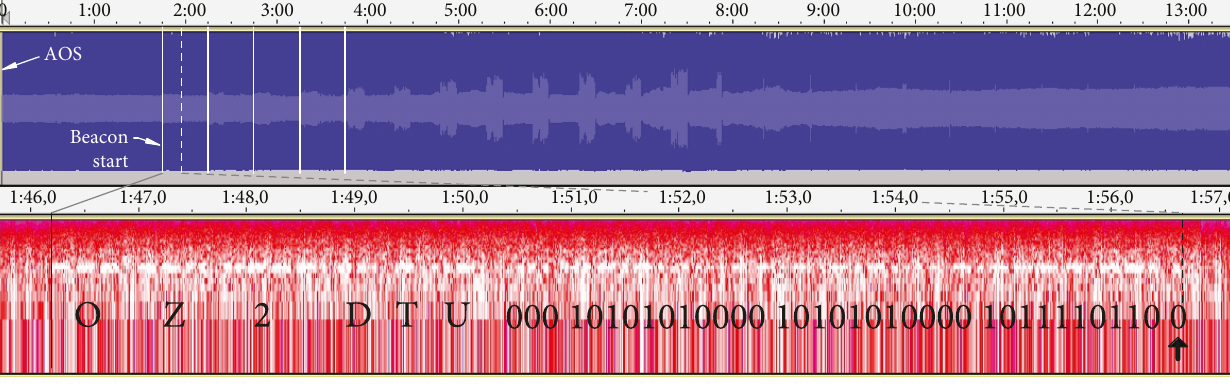
Figure 8: The top image shows a full pass recorded on 18 th March 2015, AOS 8:06 UTC, displayed in Audacity. The lower image is a zoom in that shows the process of decoding the fi rst recorded beacon of the pass, which appears 1 minute and 46 seconds into the pass. The arrow at the end of the beacon indicates the beacon count